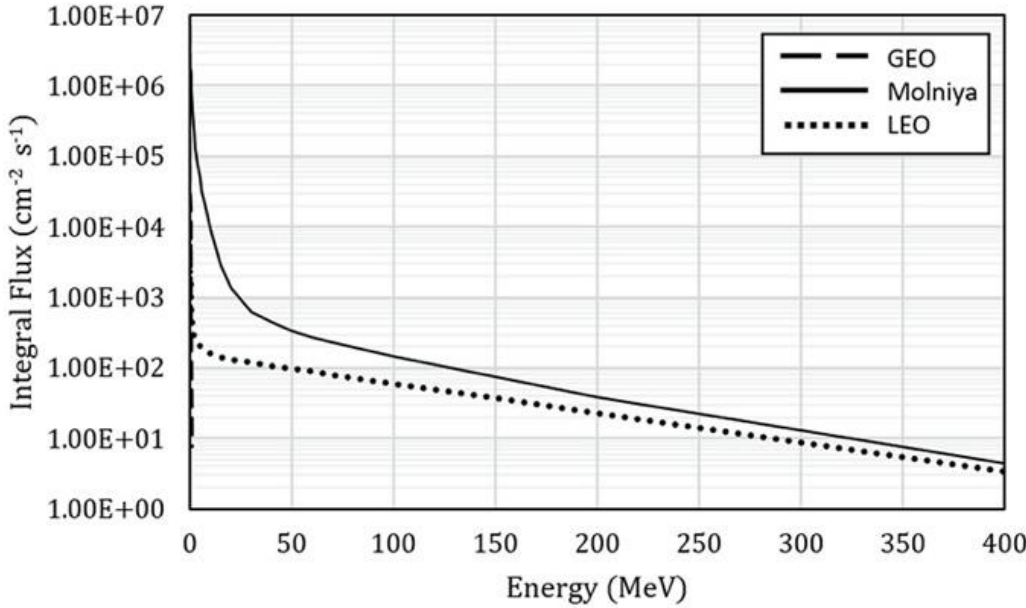
Figure 19. Average integral flux of trapped protons in LEO, GEO and Molniya orbit.